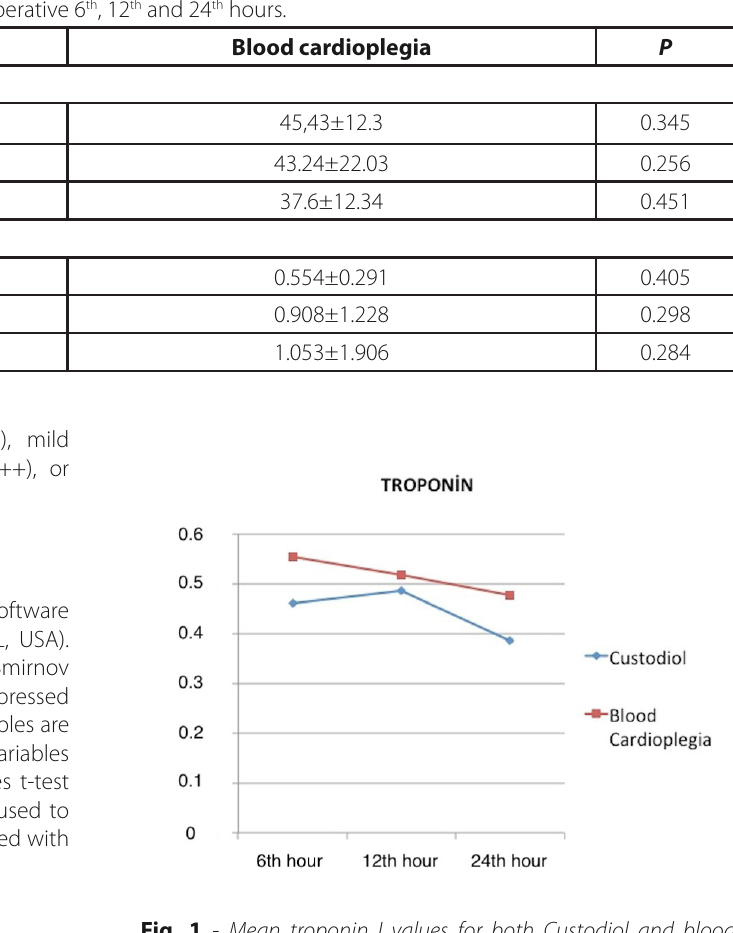
Fig. 1 - Mean troponin I values for both Custodiol and blood cardioplegia groups in 6 th , 12 th and 24 th hours after the cross-clamp was removed.